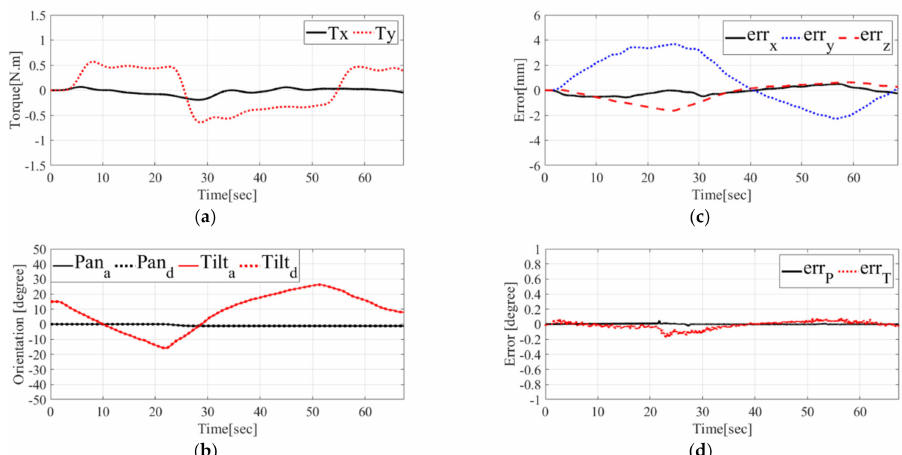
Figure 9. Experimental results in Tilt motion: ( a ) measured torque; ( b ) trajectory of desired and actual orientation; ( c ) position error of remote center; ( d ) orientation error of motion.